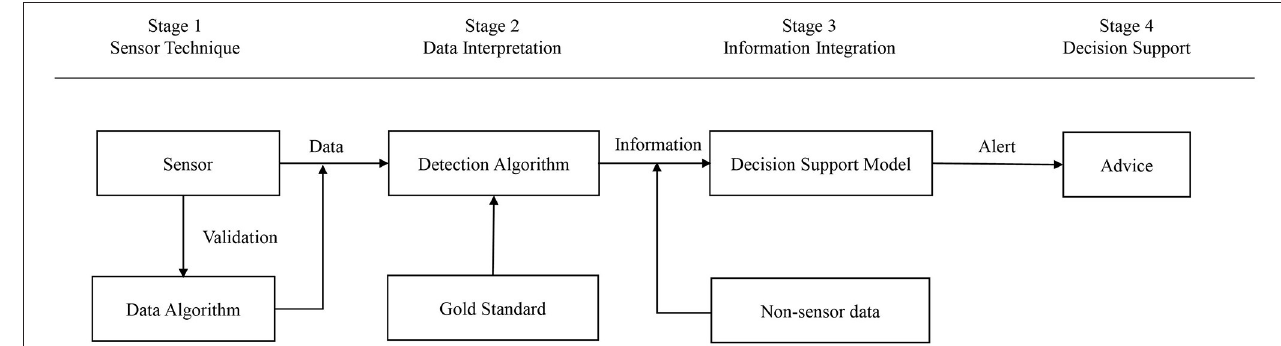
FIGURE 1 | Four-stage development